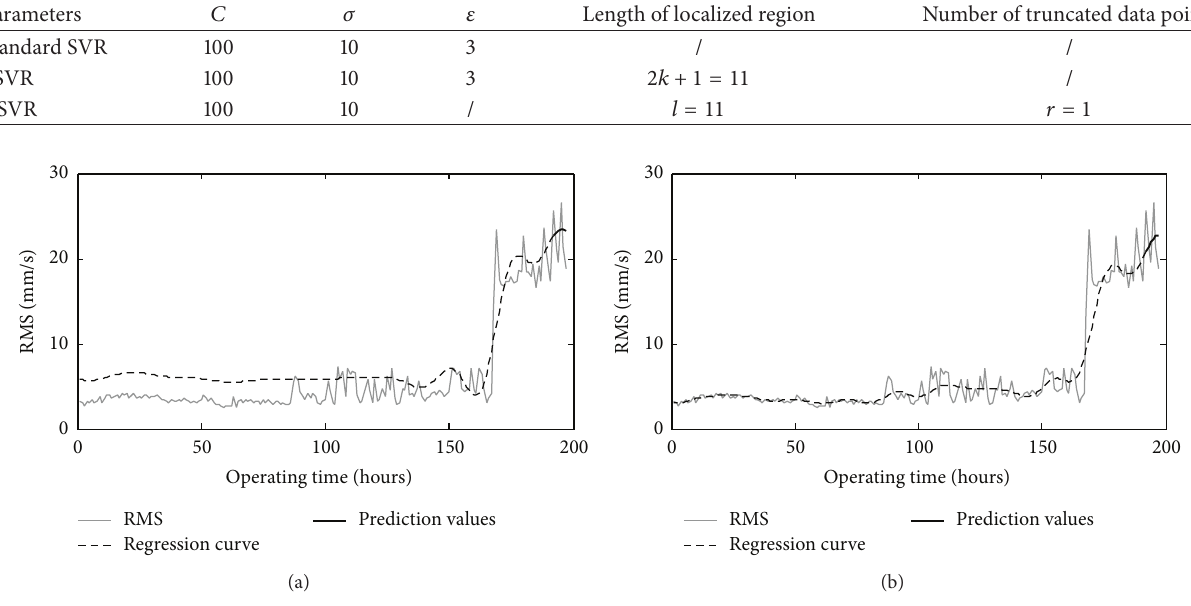
machines, respectively, are presented in Figures 3(b)–3(d), and the margins of each error-insensitive tube are also